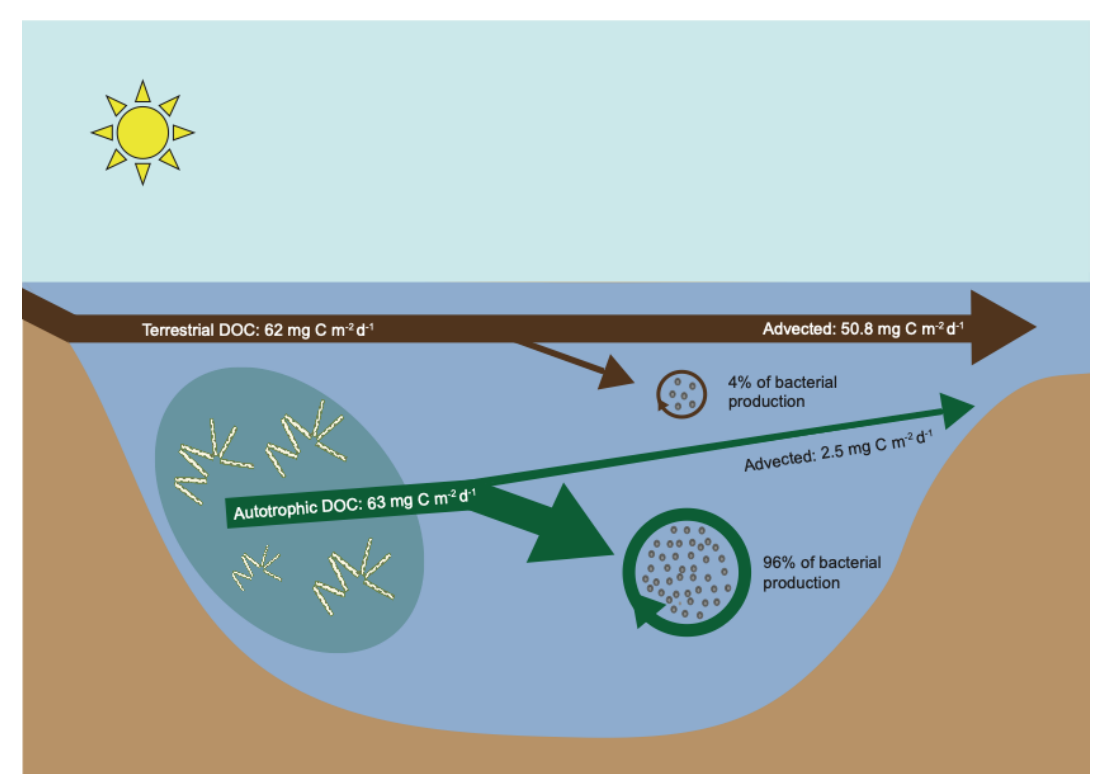
Figure 1. A schematic image of the “Median Lake” including terrestrially-derived dissolved organic carbon (DOC) and DOC released from autotrophic primary producers. The terrestrially-derived carbon supports 4% of the bacterial production whereas autotrophic derived DOC supports 96%. See Table 1 for details. Table 1. Calculations of the dissolved organic carbon (DOC) metabolism in the “Median” lake. The table includes parameter, unit, primary production (PPr) and terrestrially-derived carbon, and reference for the value or the calculation from where it was derived.